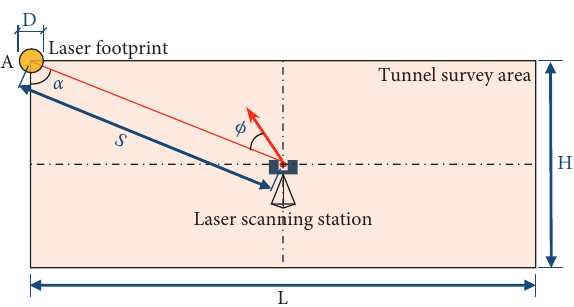
Figure 7: Schematic diagram of scanner measurement accuracy.